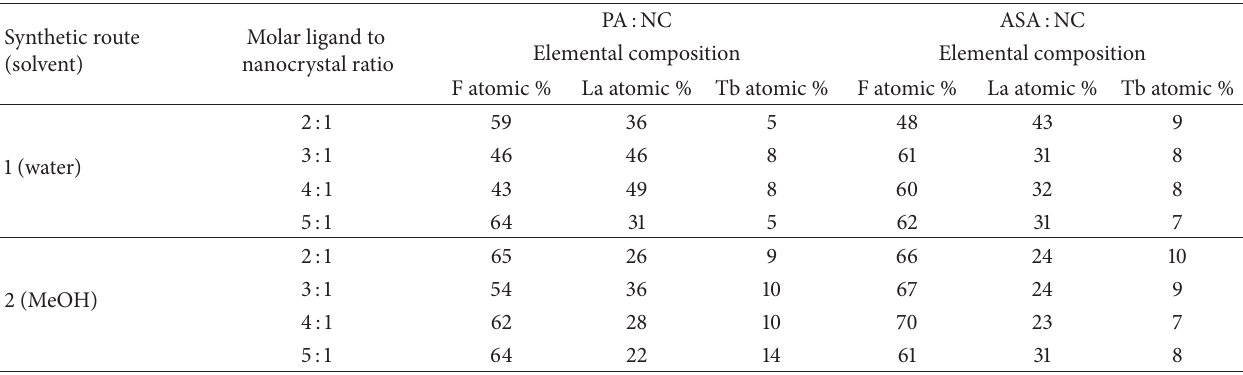
Table 4: Inorganic elemental composition and corresponding atomic percentage of nanoparticles synthesized in water and methanol at different molar ligand to nanocrystal ratios. Synthetic